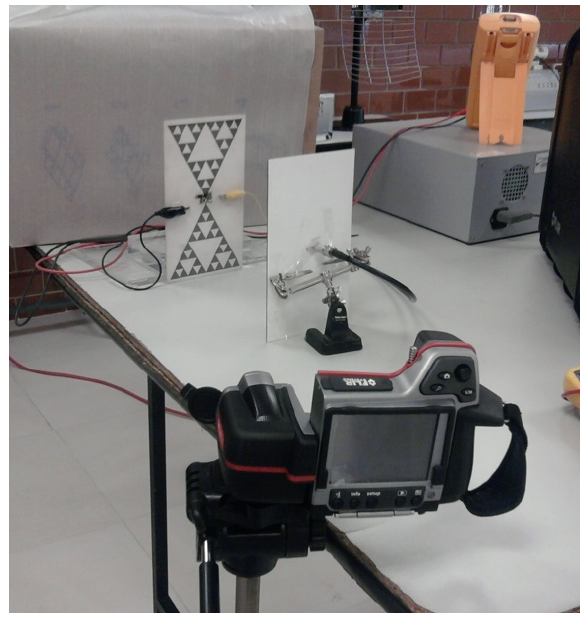
Figure 3. Experimental setup including RFG, TA, AUT, IR camera, and multimeter.